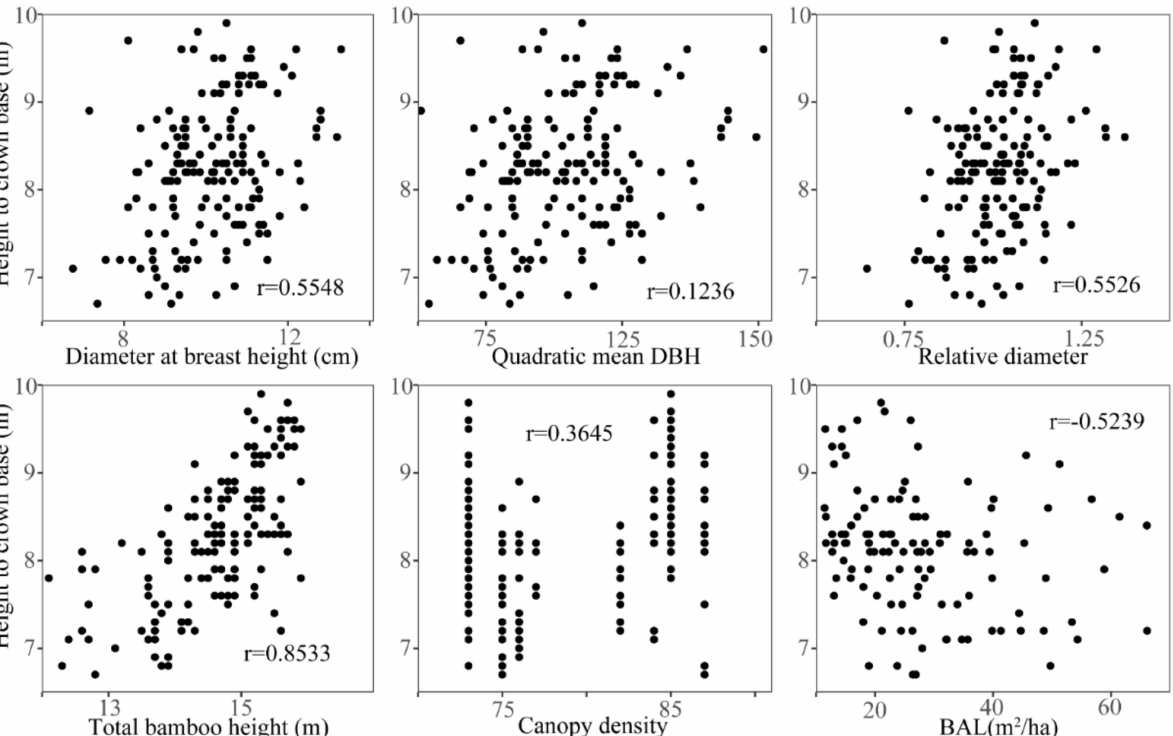
Figure 3. Scatter plots distribution between height to crown base (HCB) and different predictor variables used for modeling HCB for moso bamboo (diameter at breast height (DBH), quadratic mean DBH (QMD), relative diameter (ratio of DBH of individuals to quadratic mean diameter; RD), bamboo height (H), canopy density (CD), and total basal area of all bamboos with diameters larger than that of the subject bamboo (BAL), r represents the correlation analysis between HCB and different variables, and the p value between HCB and each variable is